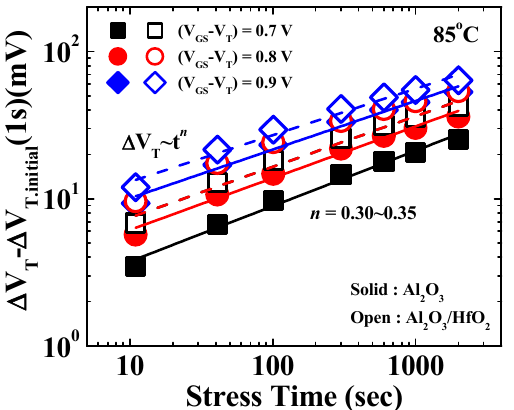
Figure 3. The power law time dependency of the observed threshold voltage degradation ( ∆ V T ) excluding the fast-transient charge trapping components ( ∆ V T – ∆ V T.initial (1 s)) in single-layer Al 2 O 3 and bi-layer Al 2 O 3 / HfO 2 gate stacks under PBT stress conditions. The power law exponent n is 0.30–0.35.